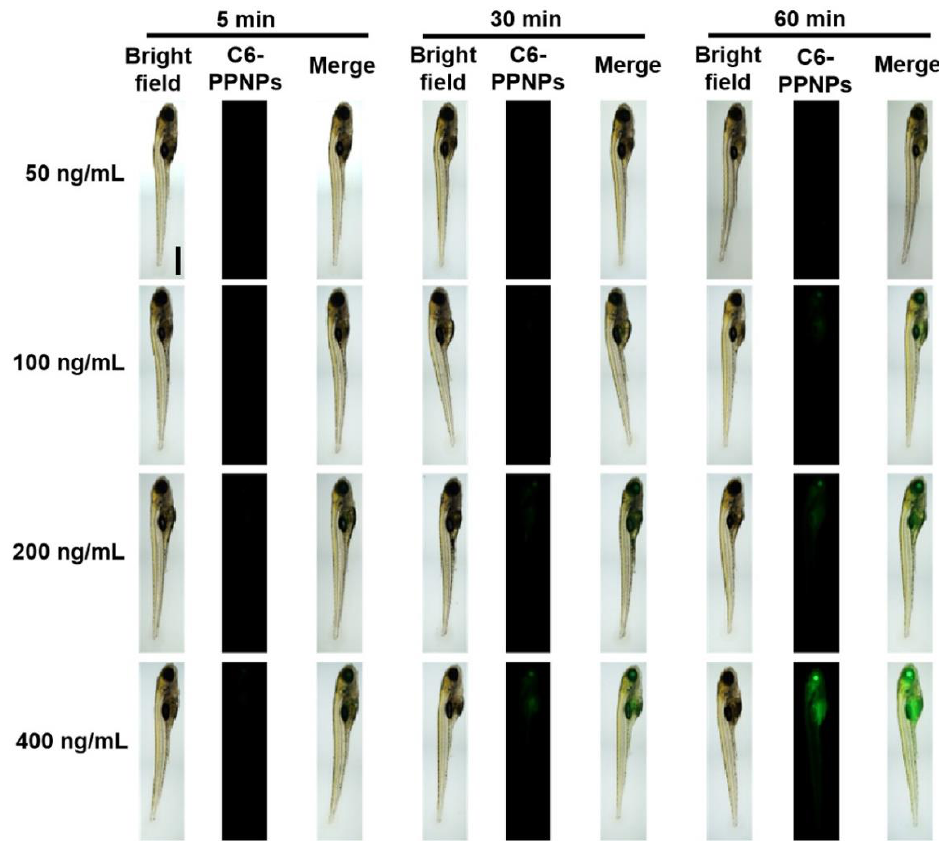
Figure 3. Imaging of zebrafish embryos. Zebrafish embryos (3 hpf) following incubation with C6- PPNPs at C6 concentrations of 50, 100, 200, and 400 ng/mL for 5, 30, and 60 min. Scale bar: 500 μm.